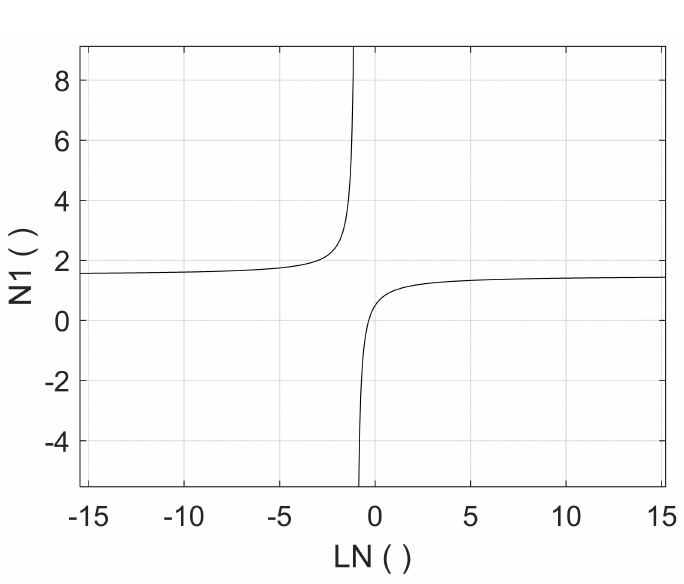
Figure 1. Relationship between the leakage exponent N 1 of the power equation and the leakage number LN of the Fixed and Variable Area Discharge